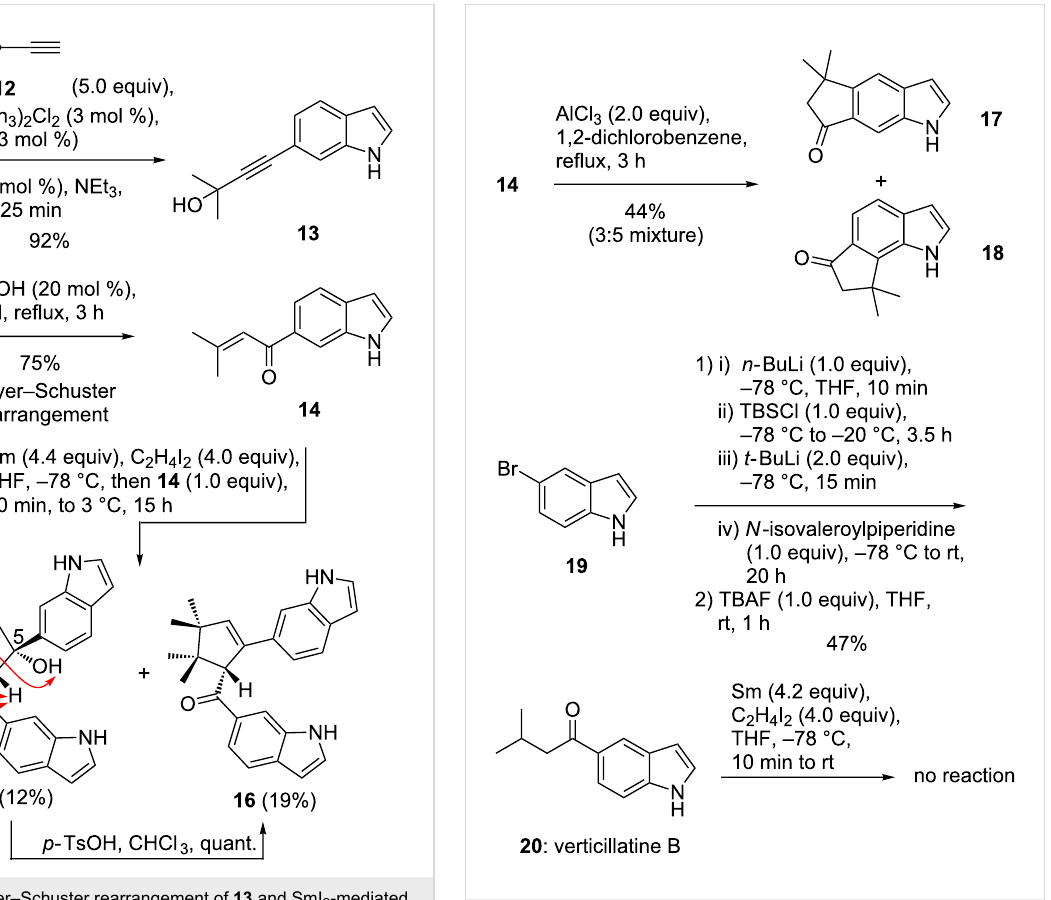
Scheme 3: Meyer–Schuster rearrangement of 13 and SmI 2 -mediated reductive [3 + 2] cycloaddition, followed by elimination to cyclopentene 16 . Selected NOESY correlations for compound 15 are